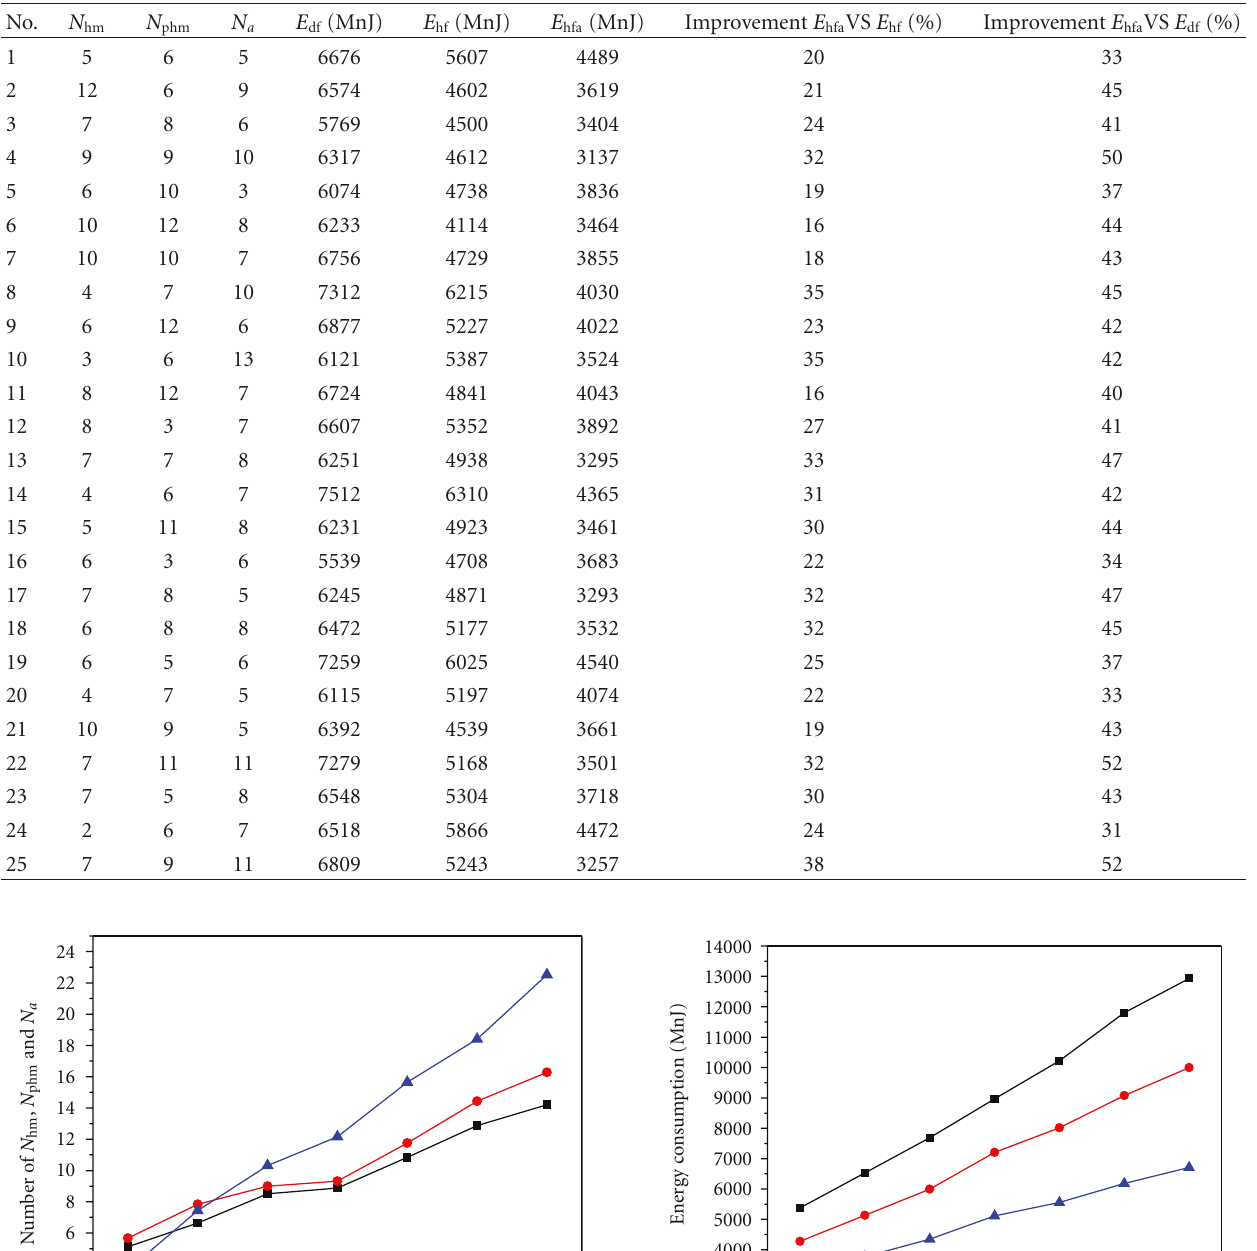
Table 3: Comparison of the Energy consumption obtained by HDQA, DF, and HDQF.